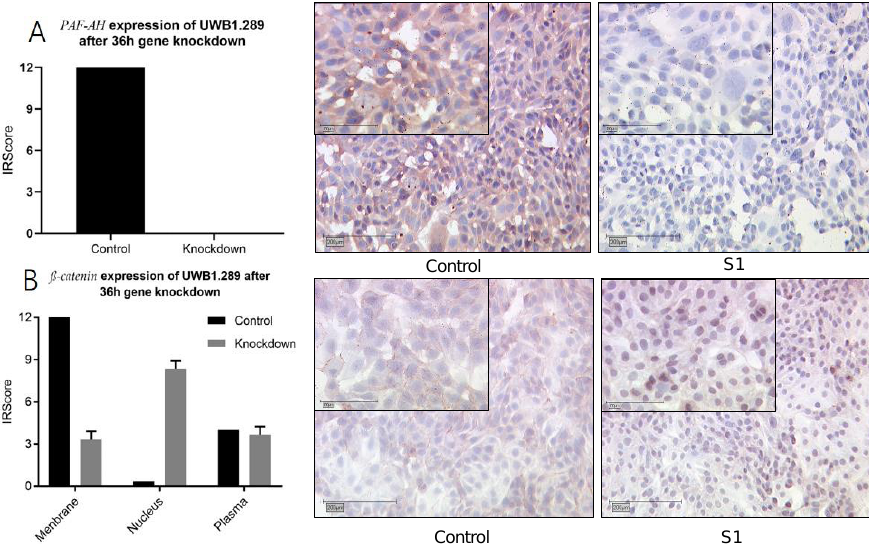
Figure 6. PLA2G7 silencing caused a shift of β-catenin from the membrane to nucleus. ICC staining of PAF-AH and β-catenin changed after 36 h silencing of PLA2G7 with siRNA (representative pictures 1. 10× magnification, scale bar = 200 µm and 25× magnification, scale bar = 100 µm). The expression of PAF-AH was downregulated as expected ( A ). The distribution of β-catenin changed by PLA2G7 knockdown from a predominantly membranous expression to a nuclear one ( B ).